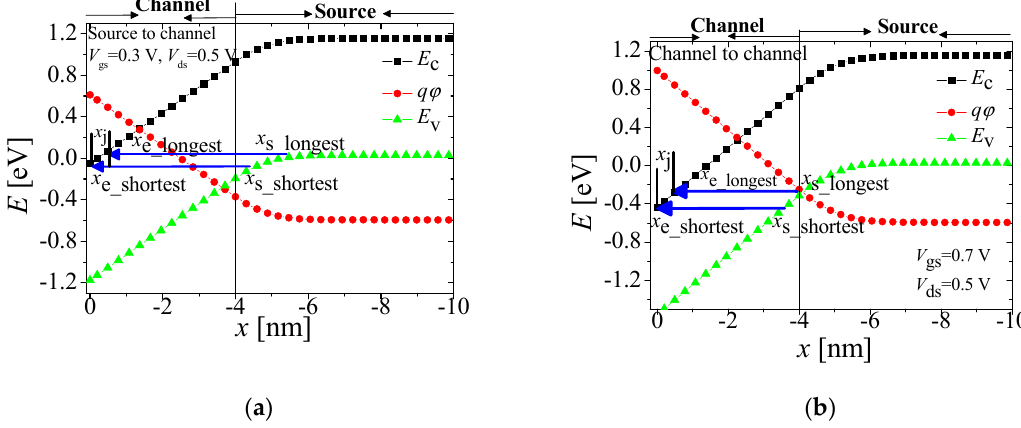
Figure 6. ( a , b ) Band diagram at V gs = 0.3 and 0.7 V, respectively, and both at V ds = 0.5 V, along the cutline of Figure 4. Black squares, green triangles, and red circles represent E c , E v , and q φ . respectively. Source-to-channel ( a ) and channel-to-channel ( b ) BTBT mechanisms are indicated with the help of arrows.